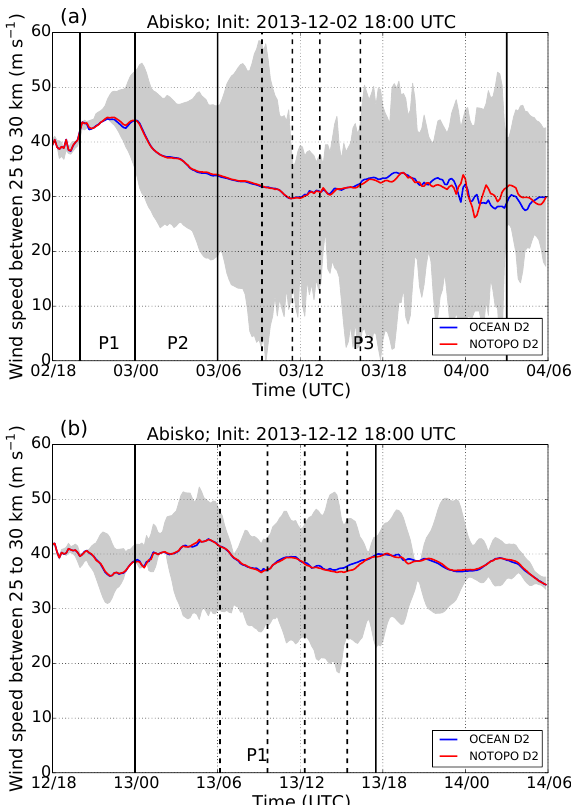
Figure 7. Time series of background horizontal wind speed av- eraged between 25 to 30km (solid lines) of the OCEAN and NOTOPO simulation at Abisko (68 ◦ N, 19 ◦ E) for (a) IOP1 and (b) IOP5. The grey shaded area marks the range of minimum and maximum wind speed perturbations (mountain-wave-induced) at 25 to 30km determined by subtracting OCEAN from CTRL simula- tion fields. All data are based on domain D2. The vertical solid and dashed lines mark the different mountain wave phases and periods of research flights as in Fig. 5.